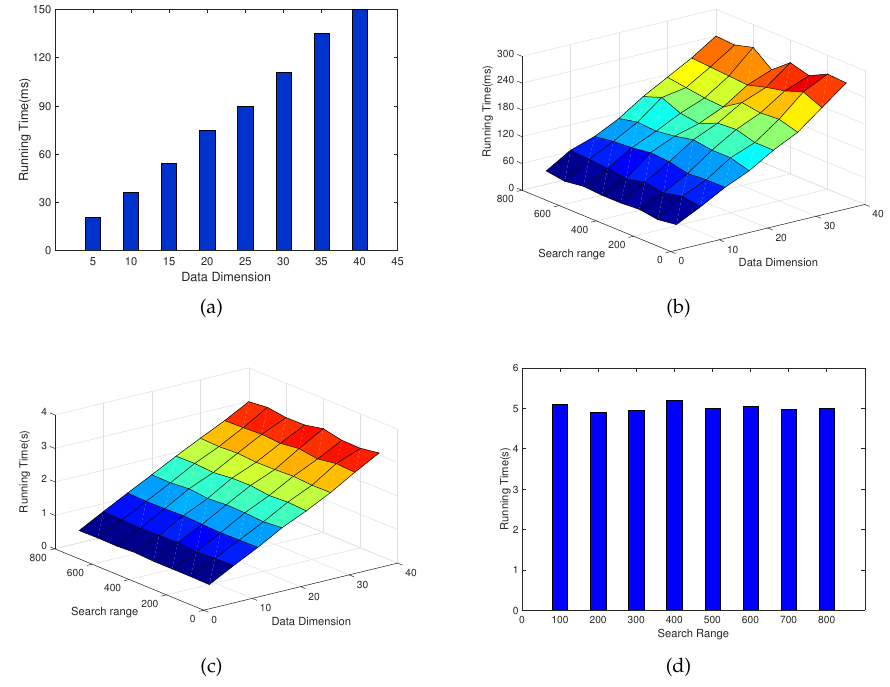
Figure 4. Computational cost of SPCQ. ( a ) Computational cost of SU in data collection; ( b ) computational cost of DU in query generation; ( c ) computational cost of CS with different search ranges and dimensions; ( d ) query response time in a real